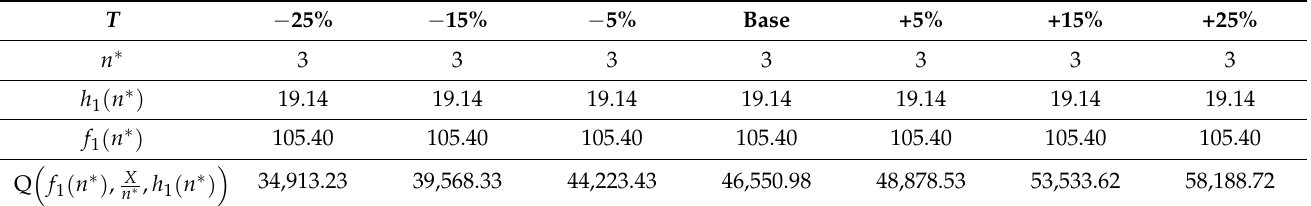
Table 10. Variation of the period of analysis T .